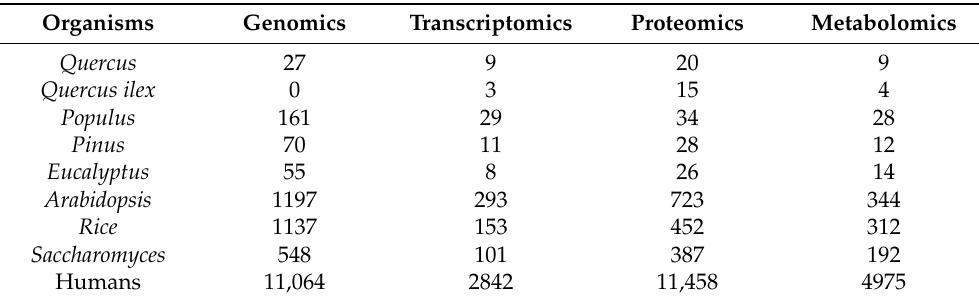
Table 1. Number of papers found in the Web of Science (WOS) database (28 July 2022) from a search using the name of the organism (first column) and the omics approach employed (second to fifth columns) as keywords (included in the